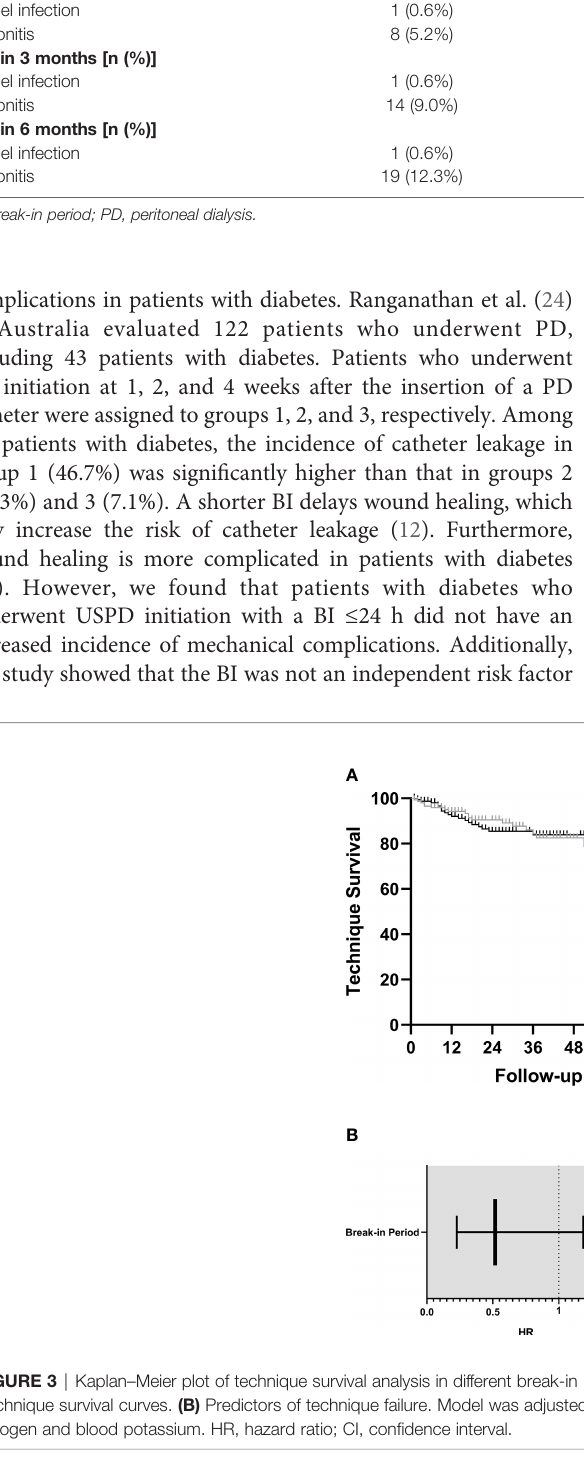
TABLE 3 | Infectious complications between different BI in diabetics with urgent PD within varies follow-up time. ≤ 24 h (n=155) > 24 h (n=155) p -value Within 2 weeks [n (%)] Tunnel